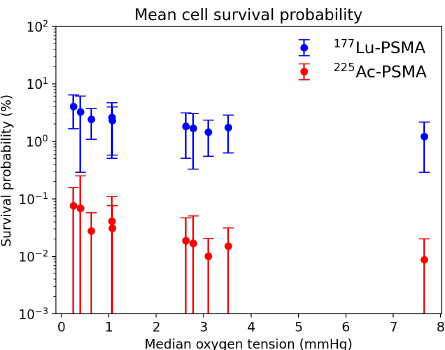
Figure 5. Cell survival probability depending on the ROI median oxygen tension for 177 Lu-PSMA and 225 Ac-PSMA treatments.